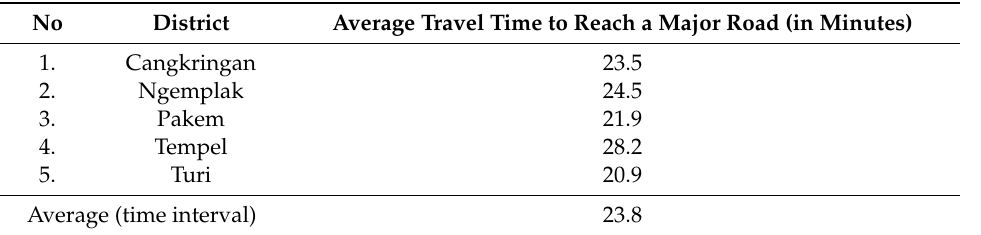
Figure 5. Population at risk’s origin and the major exits for calculating the average travel time to reach the major evacuation routes. Table 4. Time intervals between the stages.